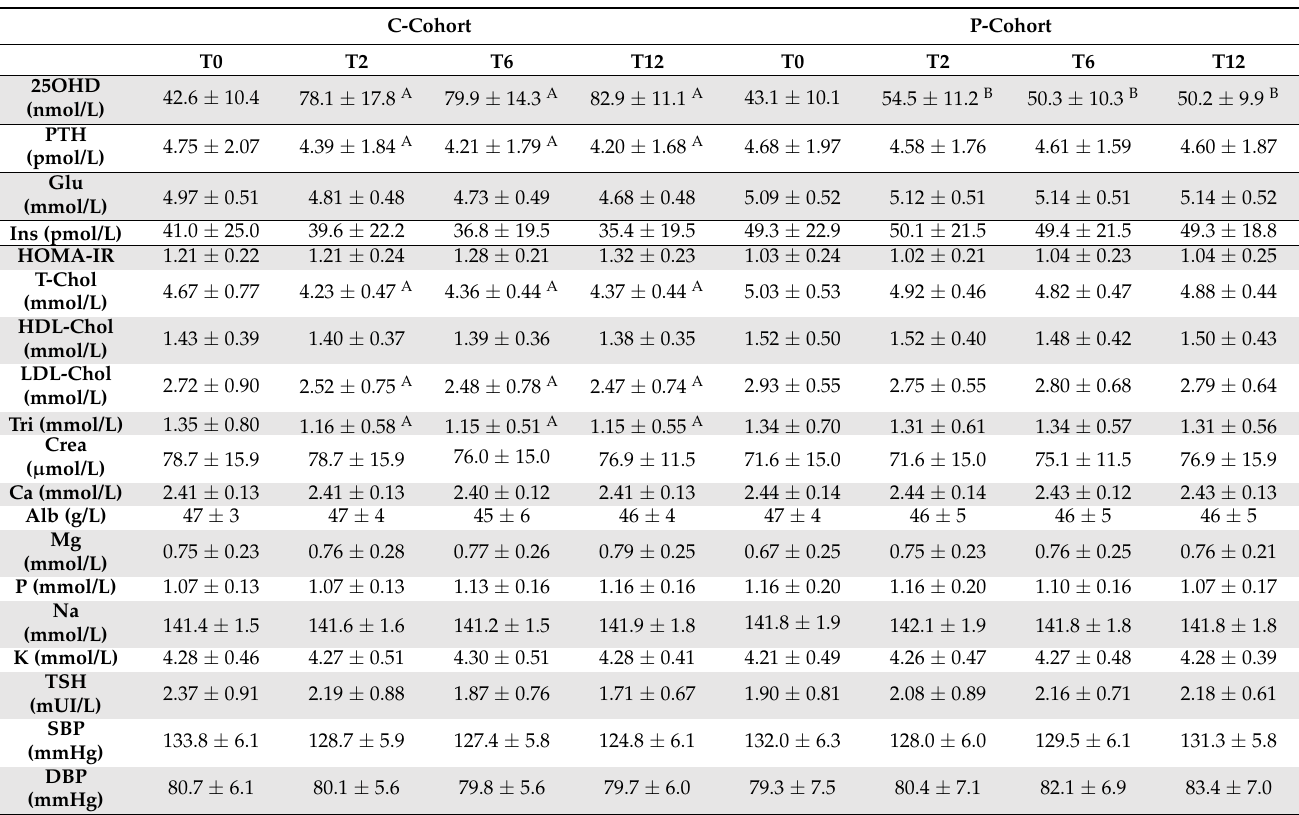
Table 2. Clinical and biochemical parameters in the HYPODD study